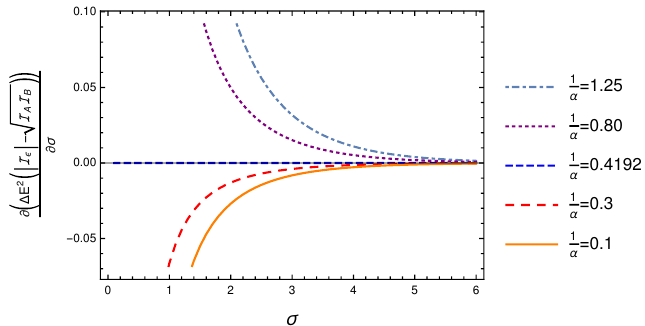
√ (cid:0) ∆ (cid:0) (cid:1)(cid:1) is plotted for two E 2 |I ε | − I A I B = α . A B